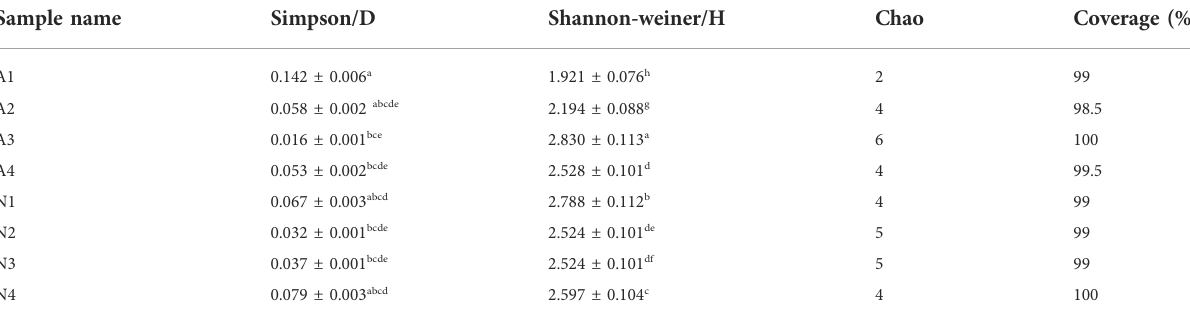
TABLE 1 Diversity level of denitrifying bacteria in the two groups.